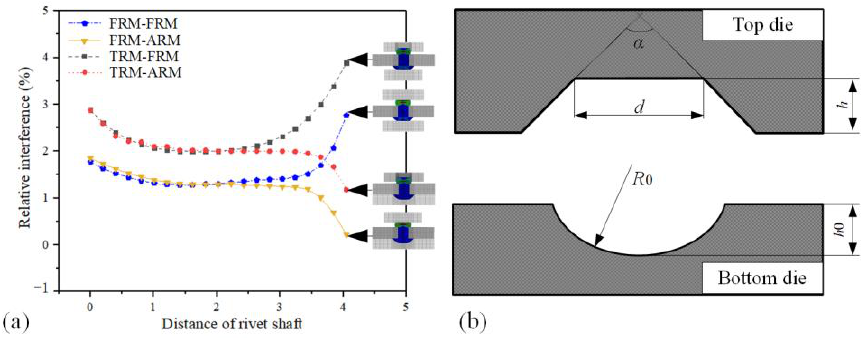
Figure 4. Simulation result of different riveting mold assembly types ( a ) Interference-fit tendency for different combinations of rivet dies. ( b ) The rivet die assembly types for a non-uniform interference-fit size.